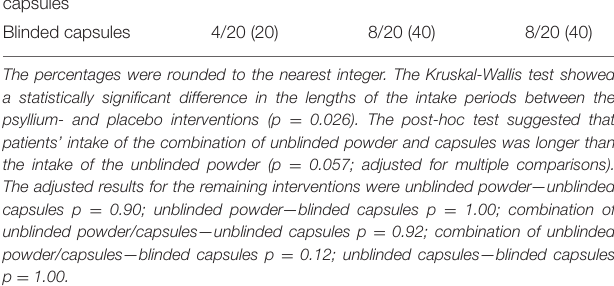
TABLE 3 | Psyllium- and placebo interventions and length of the intake period ( n = 52). Median IQR Range Psyllium- and placebo